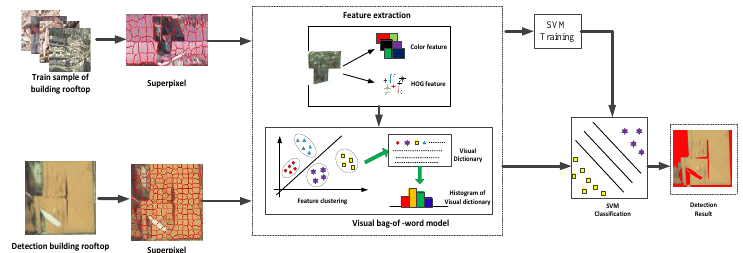
Fig.2 Flowchart of the proposed method for detecting rooftops damaged areas. algorithm[16]. SLIC can clusters pixels in the combined five-dimensional color and image plane space to efficiently generate compact, nearly